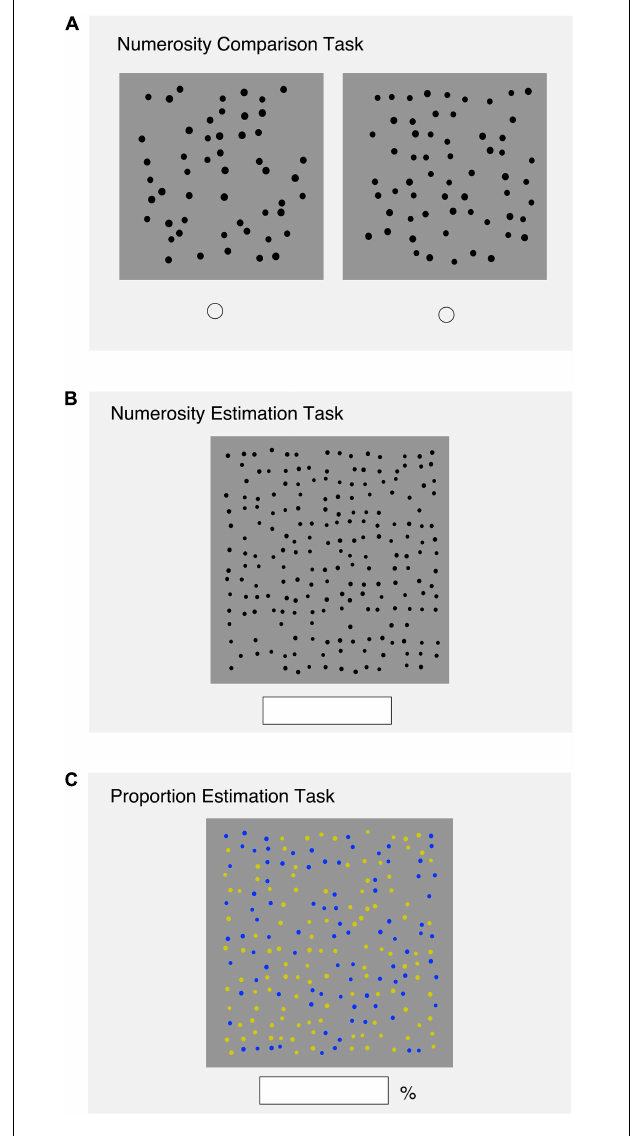
FIGURE 1 | (A) An illustration of the numerosity comparison task. (B) An illustration of the numerosity estimation task. (C) An illustration of the Proportion estimation